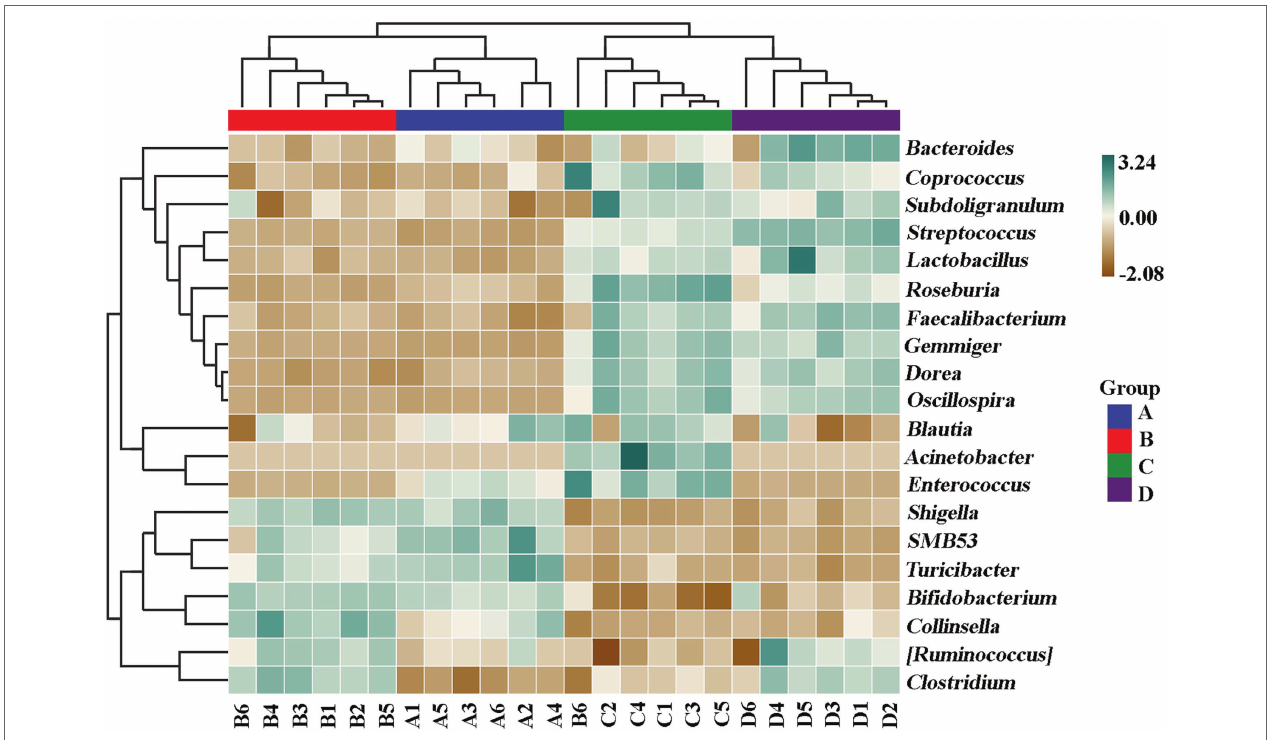
FIGURE 11 | Composition and distribution of the main 20 genus among samples ( n =